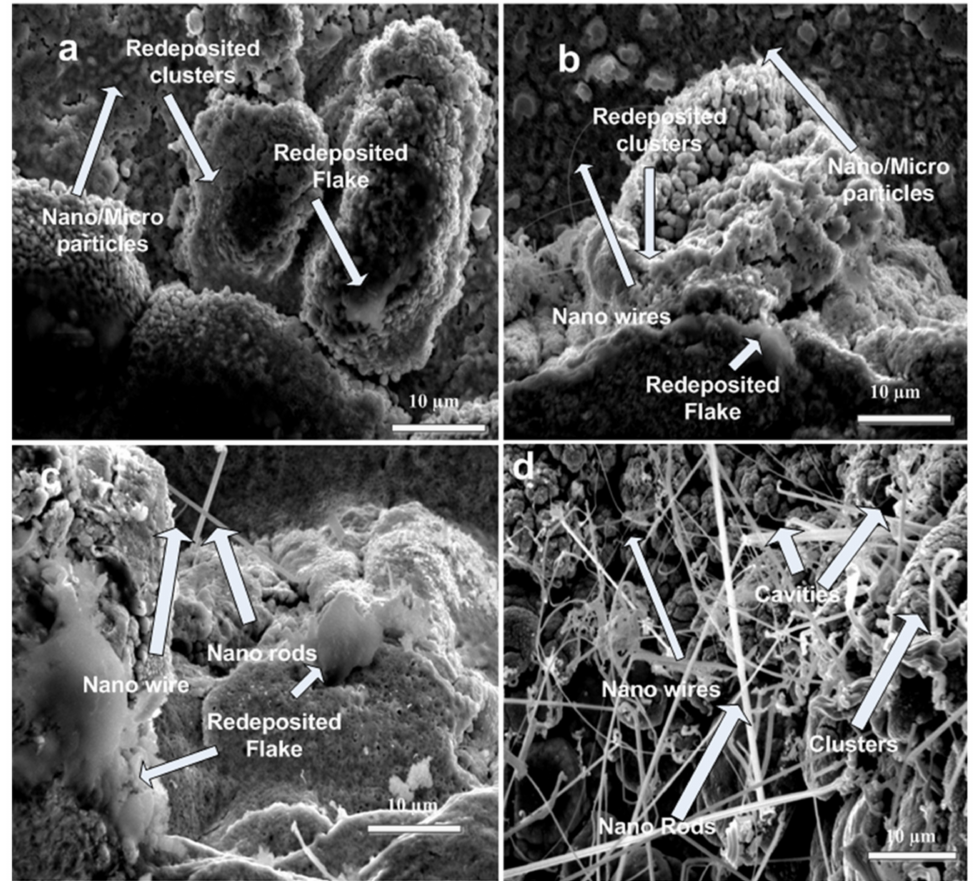
Figure 3. SEM topographical images at periphery of laser-ablated areas of Cd targets for ( a ) 500, ( b ) 1000, ( c ) 1500 and ( d ) 2000 laser pulses, at constant fluence of 3.6 J cm − 2 in